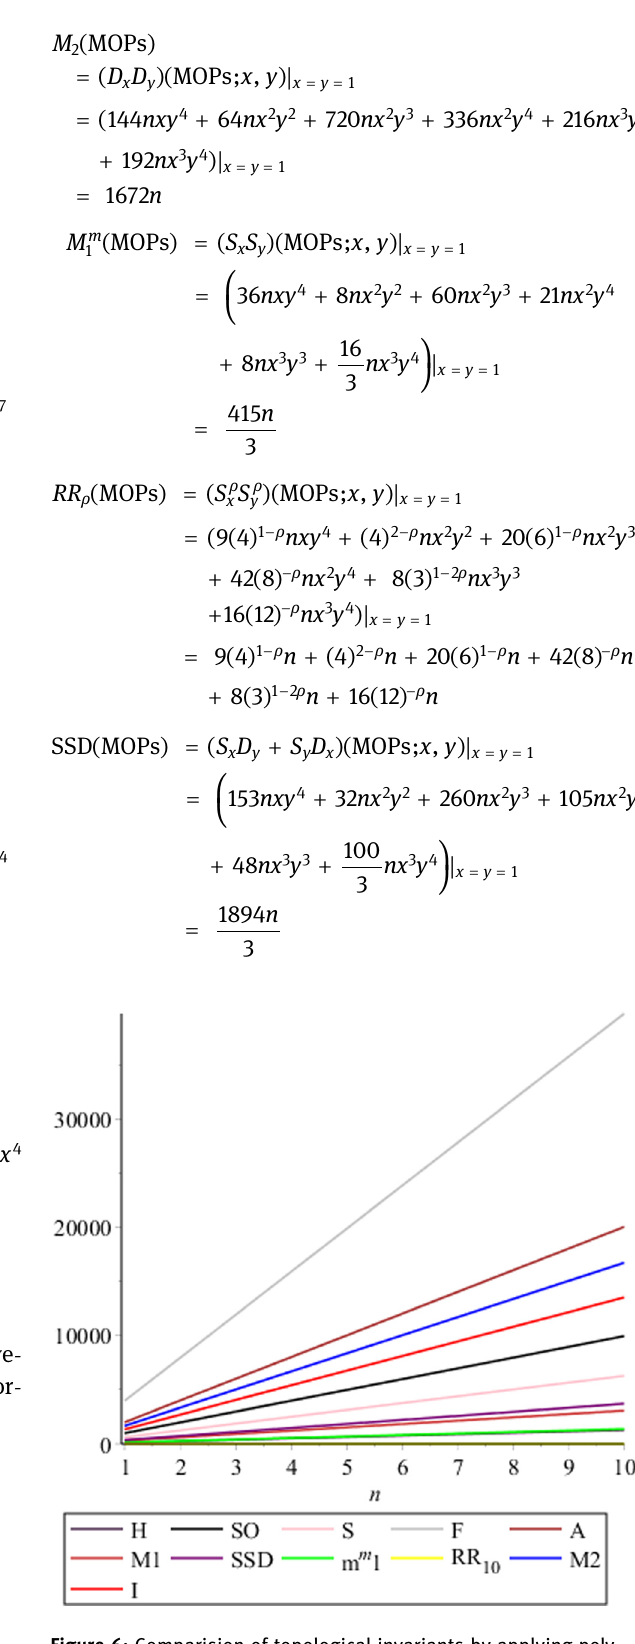
Figure 6: Comparision of topological invariants by applying poly